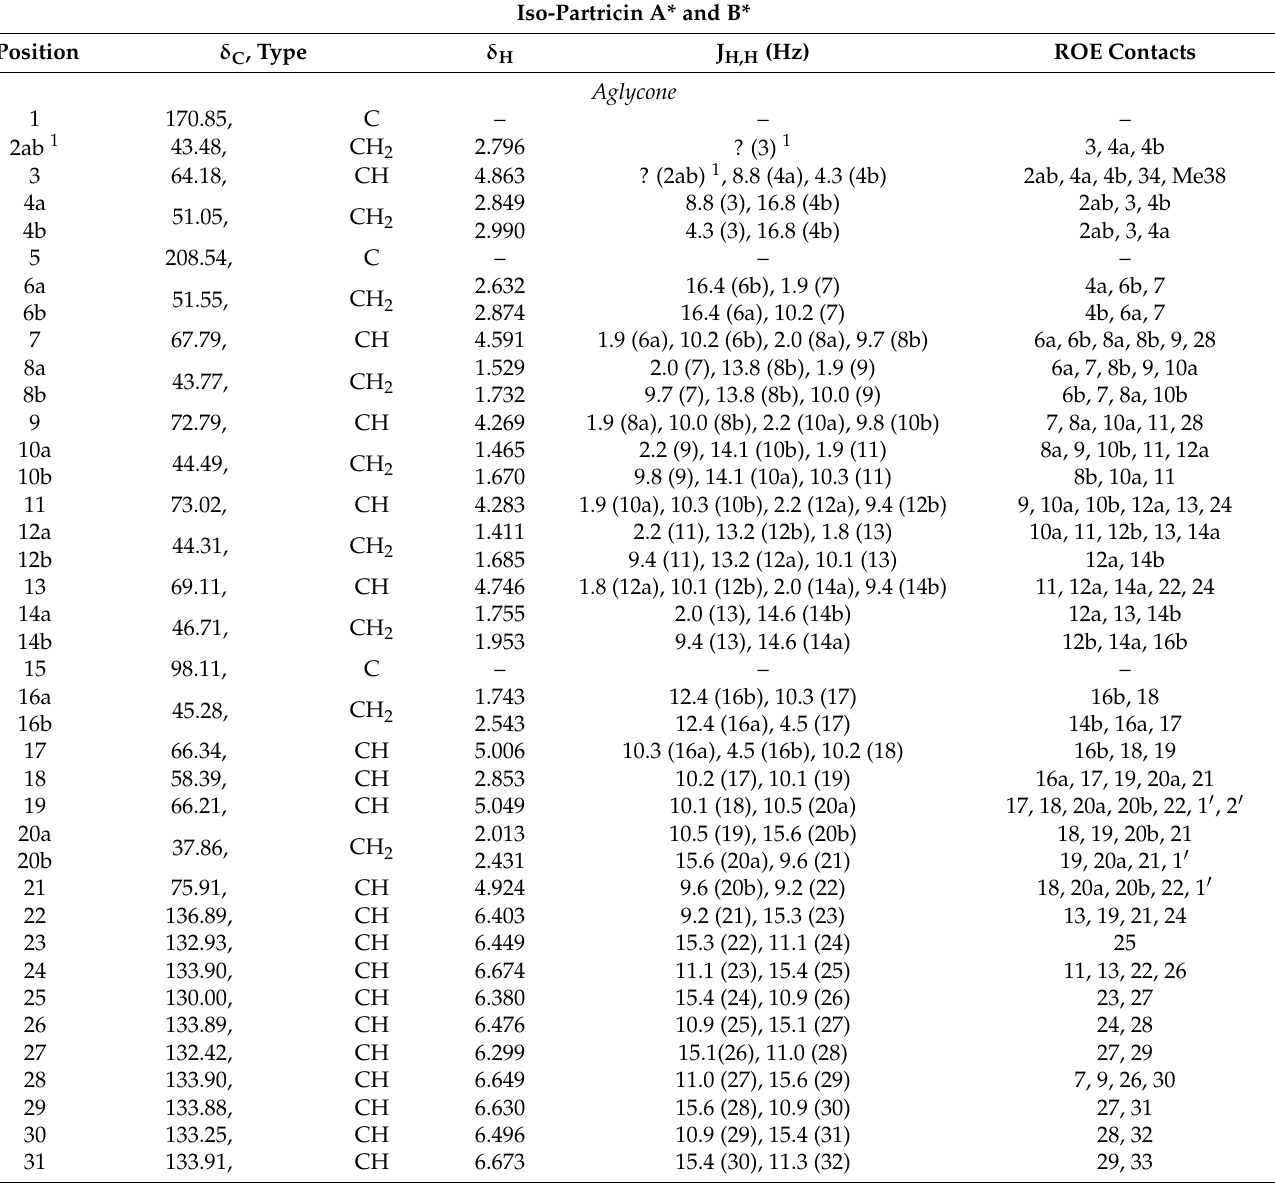
Table A1. 1 H and 13 C NMR spectroscopic data for iso-partricin A* and B* (700 MHz, C 6 D 5 N/CD 3 OD (9:1, v / v )). In every column, the letter A stands for spectroscopic data for iso-partricin A*, and the letter B stands for the analogous value for iso-partricin B*, whereas no letter given means that the presented data are identical for both